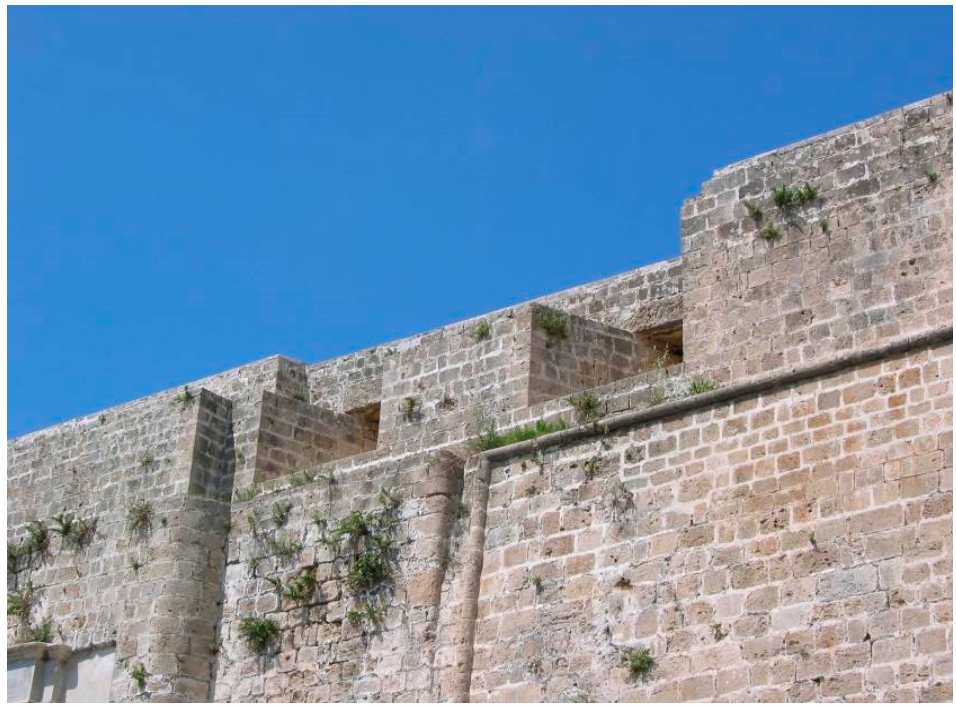
Figure 15. Acre historic wall with the lime-mortar bed joints (source: https://commons.wikimedia.org/wiki/File:Acre_-_wall.JPG. Accessed on 11 November 2020).